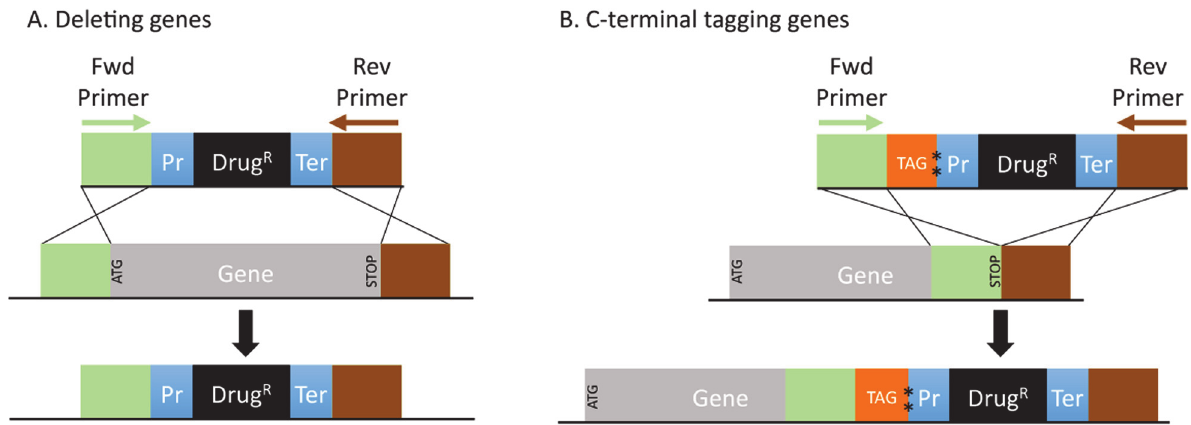
Figure 1. Transformation for deleting or C-terminal tagging genes in yeast. (A) To delete a gene, PCR-generated DNA fragments containing a selectable marker (Drug R ) flanked by target gene homology (green block, upstream of start codon (ATG), and brown block, downstream of stop codons) are used to transform yeast cells. Recombination between the DNA fragment and the genomic locus deletes the gene and replaces it with the selectable marker. Terminal homologies used in transformation are embedded within especially designed long primers (shown as green and brown arrows) which are used to amplify the transforming DNA fragments from a series of previously described vectors (3,4). Primer design involves selecting the correct regions of homology (length = N basepair) relative to the target gene. For the forward (Fwd) primer, ATG plus N-3 bp upstream of the start codon is selected. For the reverse (Rev) primer, the stop codon and N-3 bp downstream of the gene is selected. For non-coding genes or other features, N bp upstream and downstream of the feature for Fwd and Rev primers is selected, respectively. (B) To add a tag to the C-terminus of a CDS, a Fwd primer (green arrow) containing N bp directly upstream of the stop codon along with Rev primer (depicted in brown as described in A) are used to amplify the fragment shown in this figure by PCR. Homologous recombination integrates the tag (orange) in-frame with the ORF, resulting in a fusion gene. The tag carries its own translation termination codon (shown as two asterisks on top of one another).